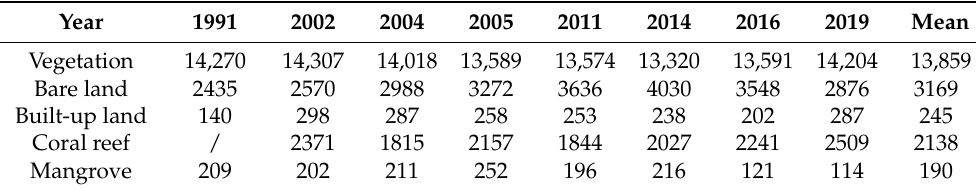
Table 3. Areas of land-use types in Fiji (km 2